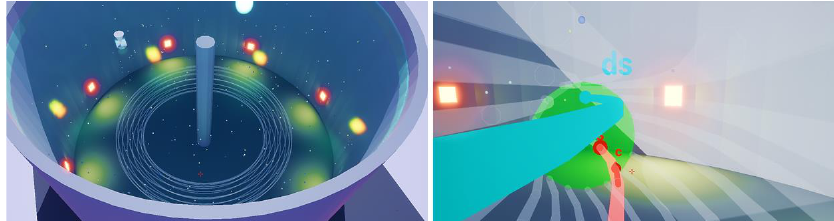
Fig. 3. Left: Vortex flow with represented flow tube. Right: Walk-through an enlarged streamline with the one-dimensional coordinate direction s (red) and the one-dimensional velocity c (red) and the